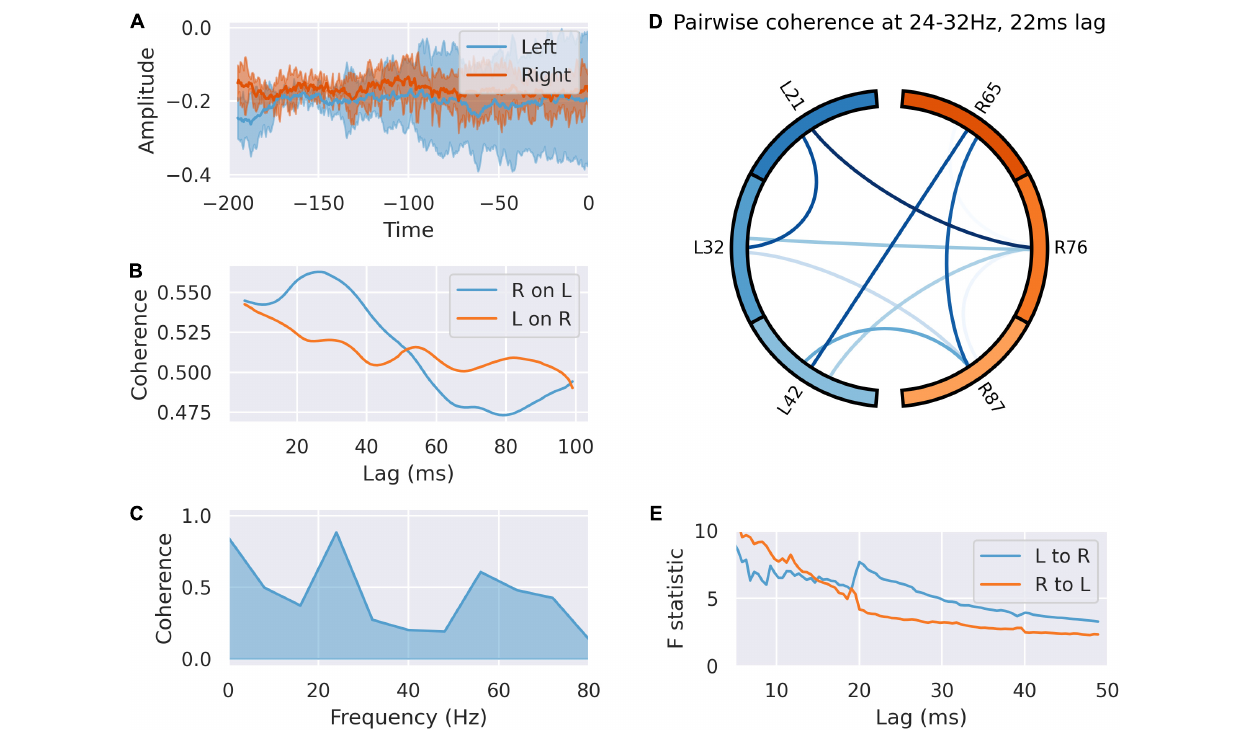
FIGURE 4 | The left dACC signals to the right during the –200 ms preparatory window. (A) Averaged responses of the left and right dACC during the –200 ms window. There is a uniform reduction in variance and phase reset across all electrodes here, suggesting coordinated activity. (B) Coherence between left and right dACC signals over a range of time lags. Peak coherence occurs between left and right dACC 22 ms later, suggesting left to right communication. (C) Coherence spectrum at 22 ms lag. The greatest coherence is seen in the 24–32 Hz range. (D) Pairwise coherence for all electrodes at 24–32 Hz with a 22 ms lag. Each area is represented by a labeled part of the external circle (L on the left, R on the right; the numbers indicate the specific electrodes used on the implanted system). The lines joining sections indicate coherence between the joined regions. The darker the color of the connection the greater the coherence between the joined regions. There is widespread coherence during this interval, suggesting coordinated activity. (E) Granger causality of signals in this interval. There is a jump in the test statistic at 21 ms, suggesting left to right communication in this